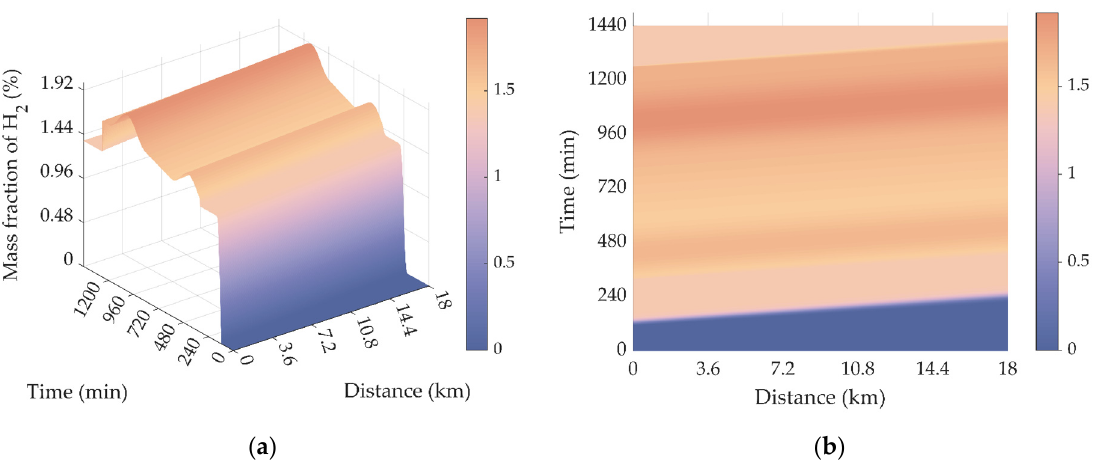
Figure 10. The distribution of hydrogen mass fraction in Pipe 3 in Scenario I: ( a ) Three-dimensional diagram; ( b ) top view.